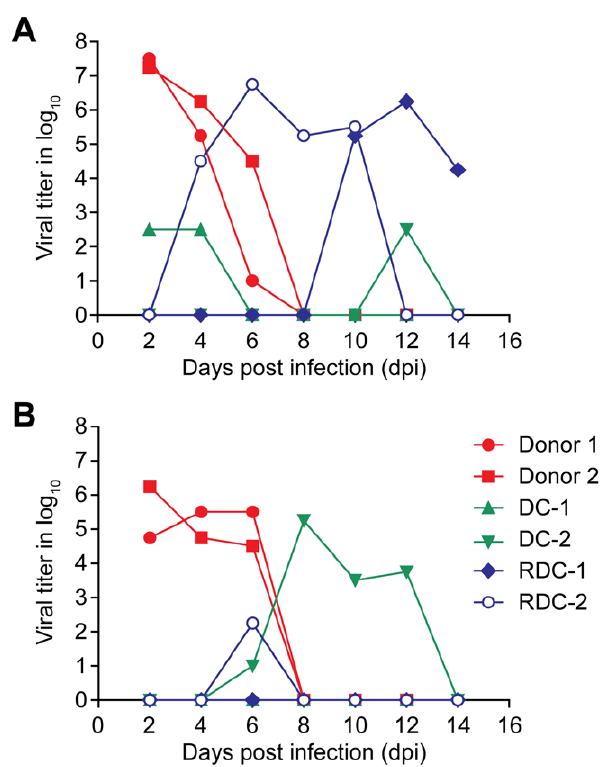
Figure 4. Transmissibility of A/shorebird/DE/300/2009 in ferrets. Viral titers were detected in (A) nasal washes and (B) rectal swabs of donor ferrets (red), direct-contact ferrets (DC, green) and respiratory-droplet–contact ferrets (RDC, blue) 14 dpi. Data from each animal are shown. Viral titers are given in terms of EID 50 .